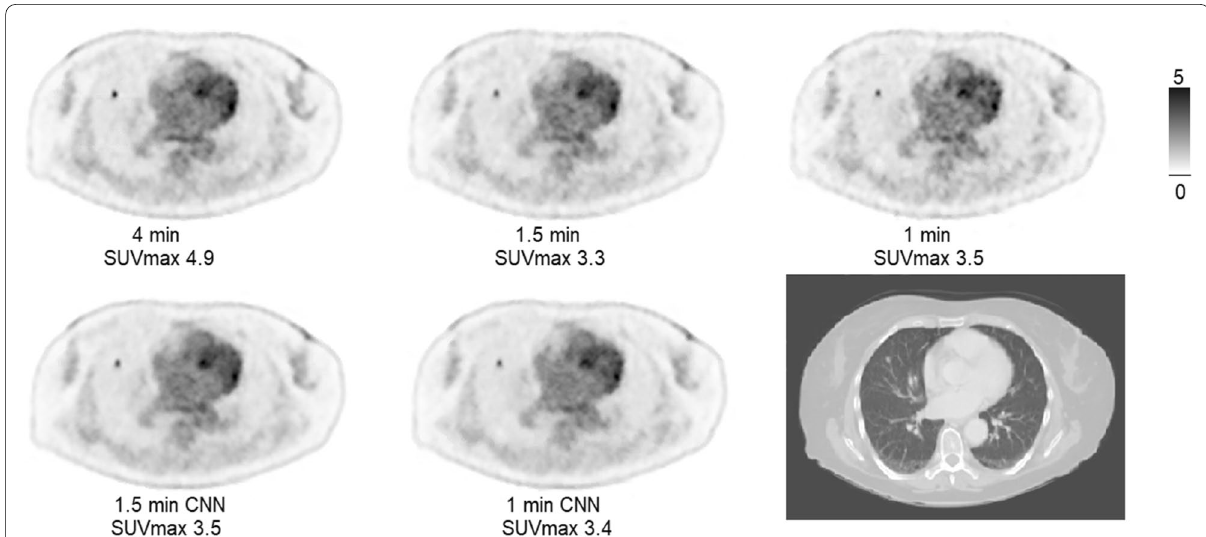
Fig. 6 Transaxial PET images of all image sets and corresponding transaxial CT image. The lung metastasis in the right lung is readily detected regardless of reconstruction and the SUV max in the metastasis is comparable for all 1 min and 1.5 min images